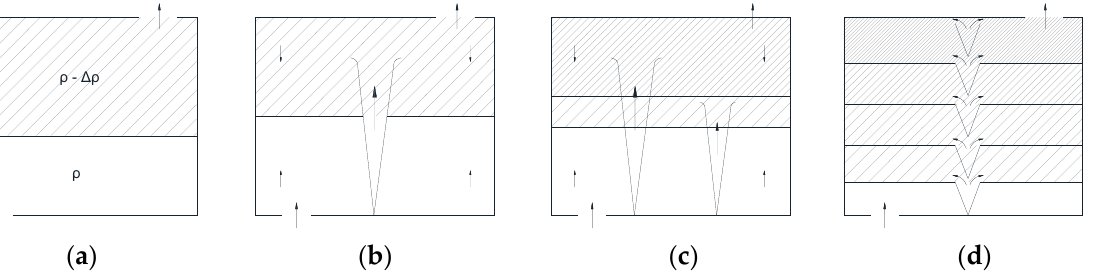
Figure 8. Vertical stratification with different buoyancy sources, including ( a ) the discontinuous buoyancy, ( b ) single buoyancy source, ( c ) two buoyancy sources with different strengths, and ( d ) buoyancy sources at different positions, adapted from Linden et al. [3].